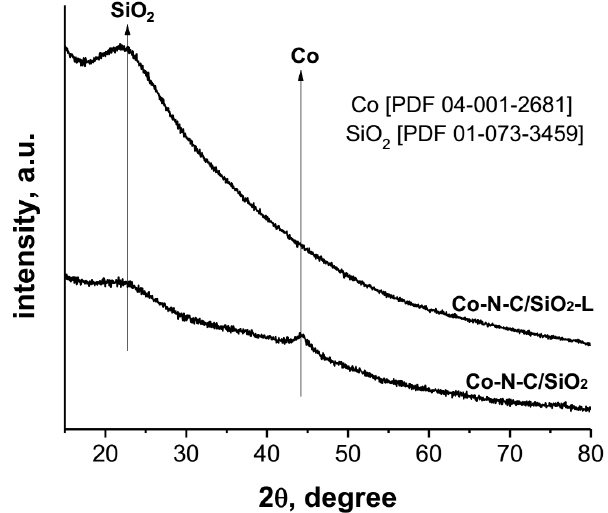
Figure 1. Powder XRD patterns of the prepared catalysts.